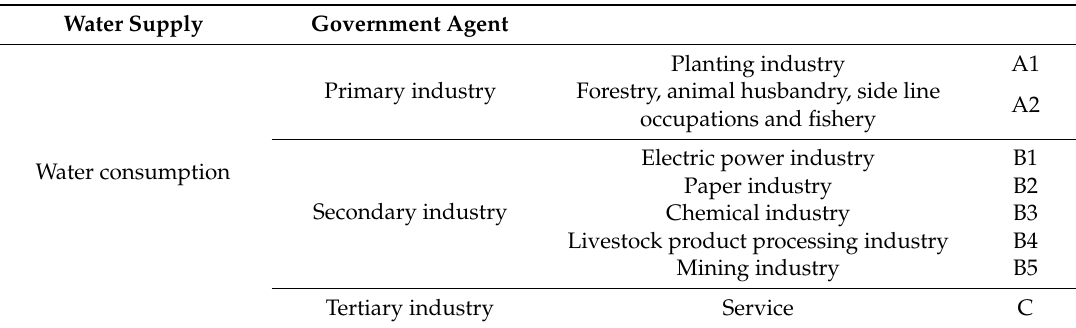
Table 1. Summary of the main agents in Bayannur City.